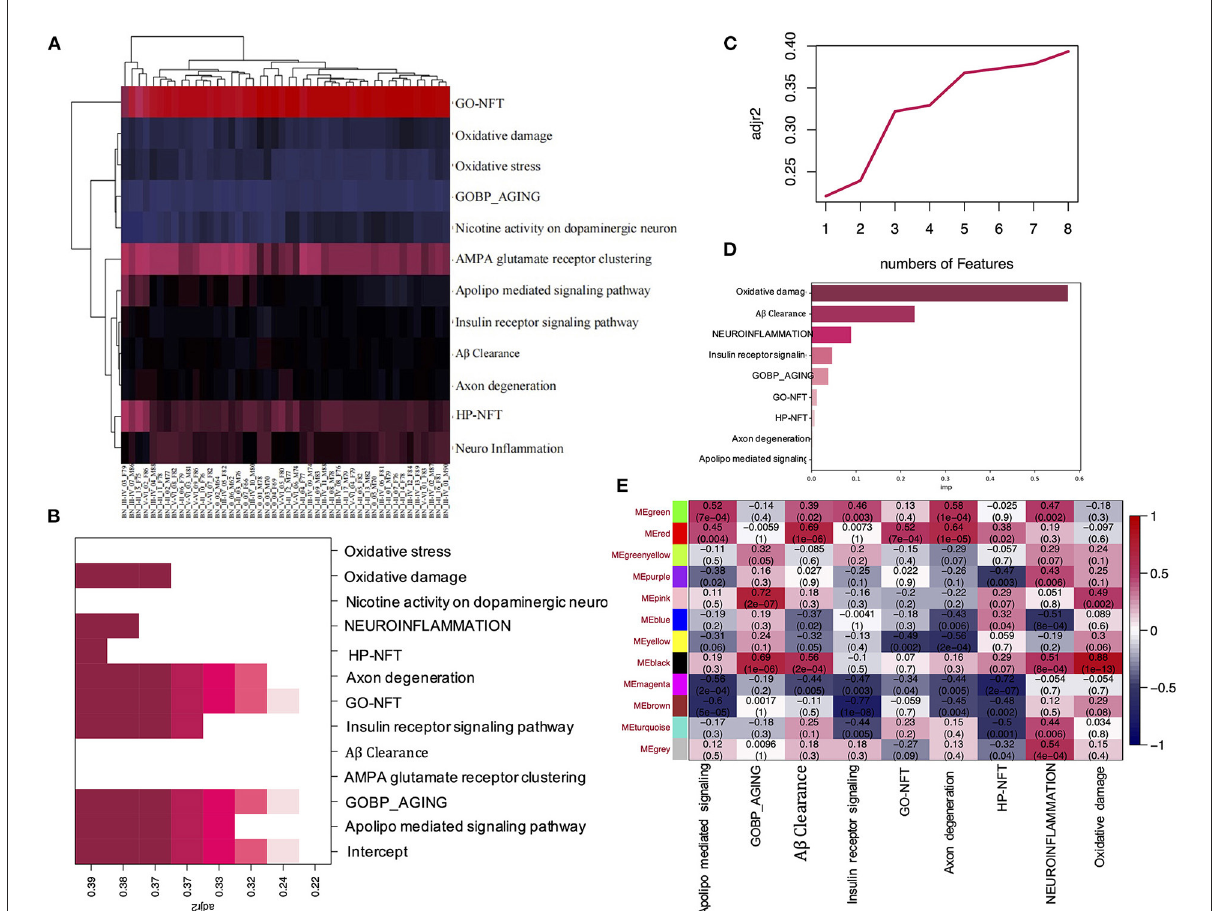
FIGURE2 ssGSEA and WGCNA analysis of the EC data. (A) Heatmap shows the ssGSEA scores of the different gene sets in corresponding samples. (B) The heatmap shows the adj R2 of the Best subset regression result of each ssGSEA pathway. (C) The plot shows the adj R2 of the number of features in the Best subset regression model. (D) The bar plot shows the importance of each ssGSEA pathway by the RF model. (E) Pearson correlation coefficient between the pathway and module eigengenes, numbers in brackets indicate the corresponding p-